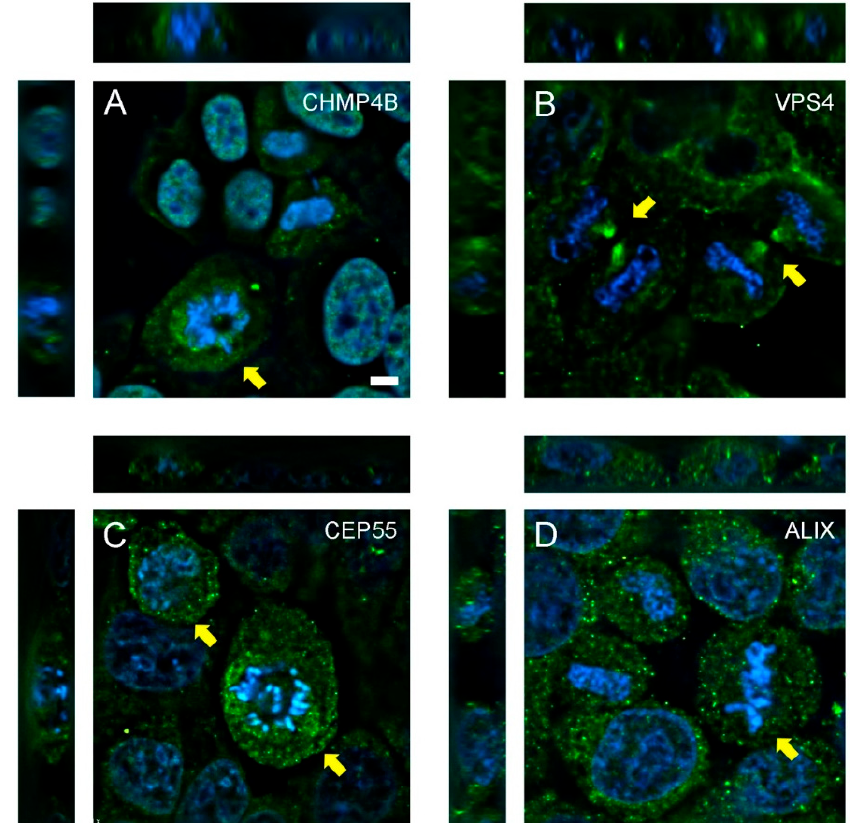
Figure 1. Localization and recruitment of abscission proteins in HeLa cells. HeLa cells were seeded onto glass chamber slides and fixed after 24 h, then stained with antibodies to ( A ) CHMP4B, ( B ) VPS4, ( C ) CEP55, or ( D ) ALIX. Proteins (green) and DAPI-labeled nuclei (blue) are shown. Z-stacking was performed to confirm localization and recruitment of proteins during various stages of mitosis, including abscission. Yellow arrows highlight specific recruitment or upregulation of abscission proteins within dividing cells. Scale bar = 10 µm.